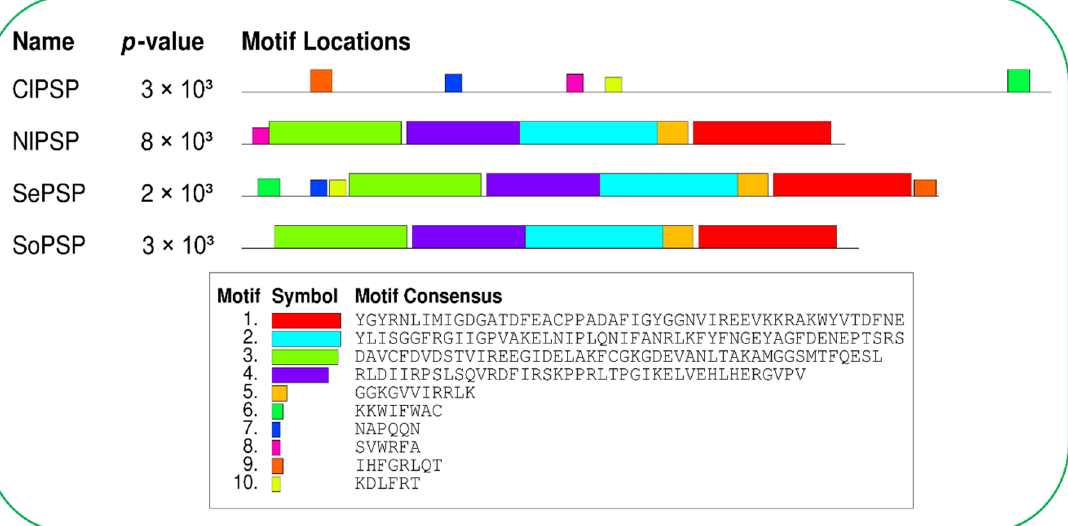
Figure 3. Schematic representation of the conserved motifs possessed by PSP protein in C. lividipennis (ClPSP), with homologs from N. lugens (NlPSP), S. exigua (SePSP), and S. oryzae (SoPSP).